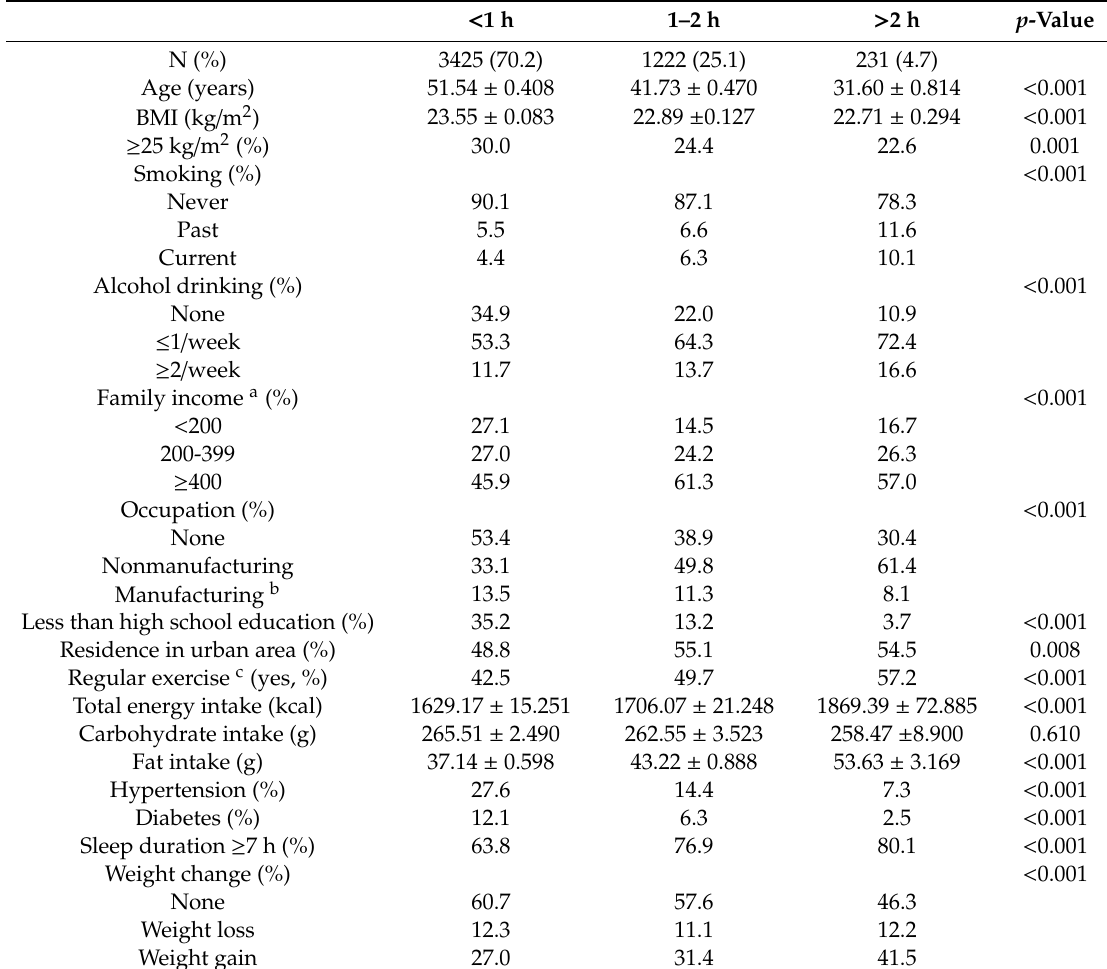
Table 4. Characteristics of the study population according to social jetlag in